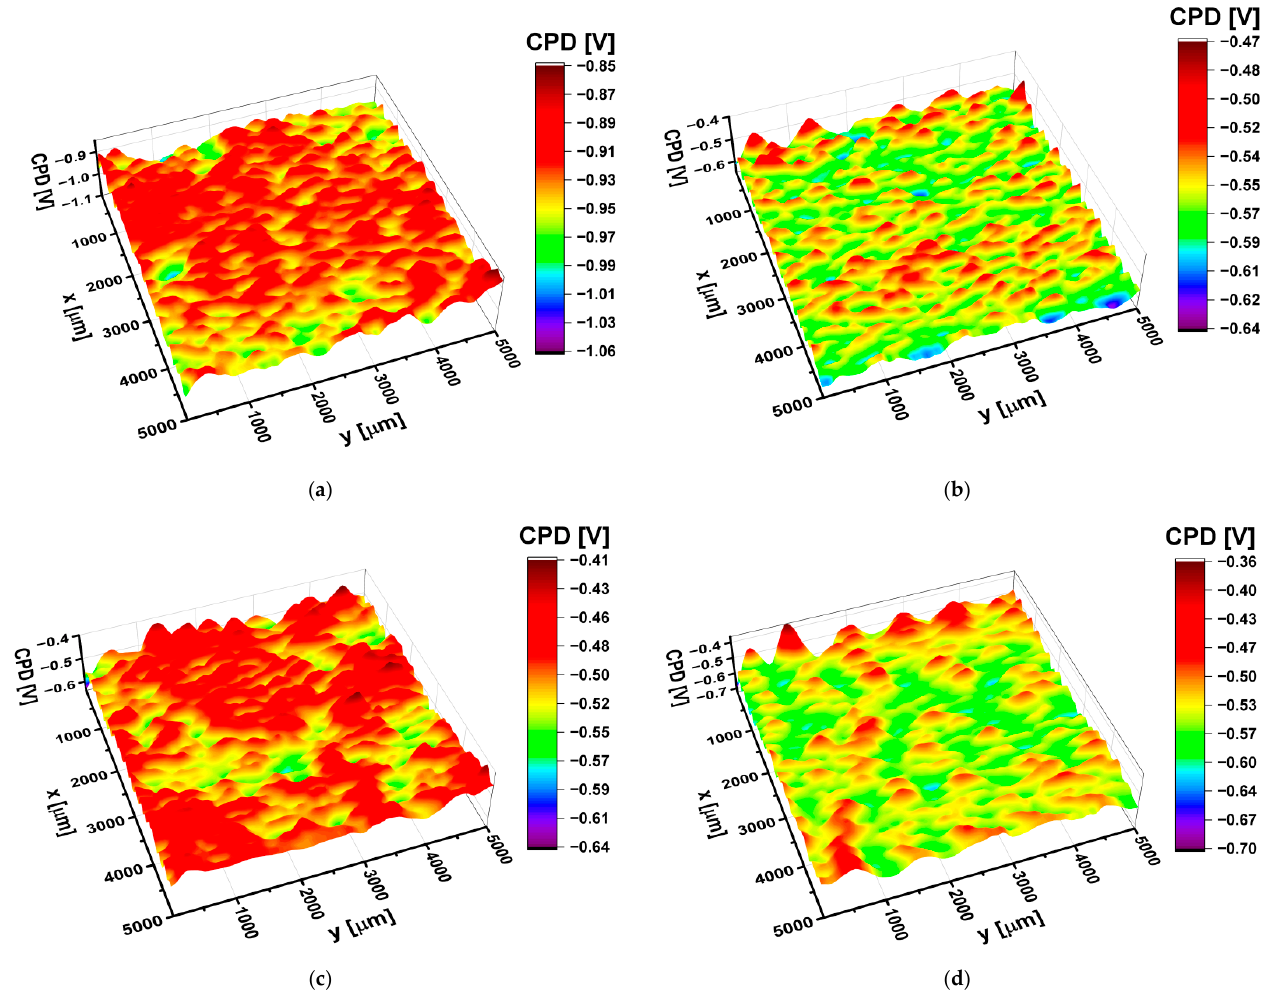
Figure 9. The contact potential difference (CPD) map for the Ti-13Zr-13Nb alloy surface: ( a ) Before anodizing; ( b ) After anodizing at 15 V for 120 min; ( c ) After anodizing at 25 V for 120 min; ( d ) After anodizing at 35 V for 120 min.